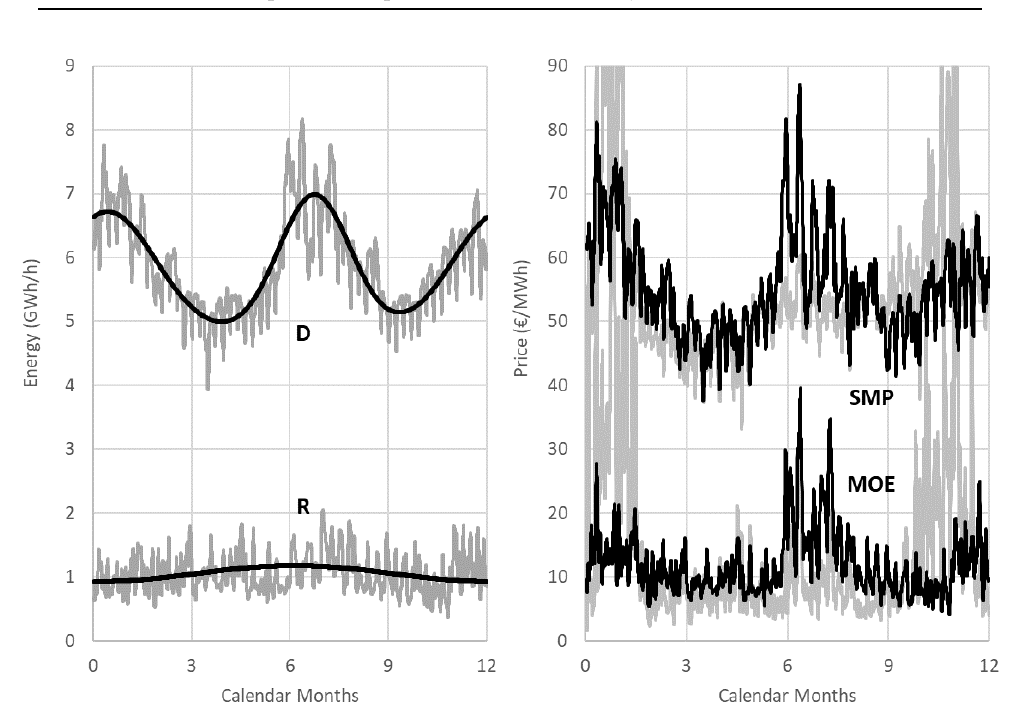
Figure 8. Seasonal variation: Comparison between real (grey lines) and model calculated (black lines) values. D = demand, R = renewables, SMP = system marginal price, MOE = merit order effect.